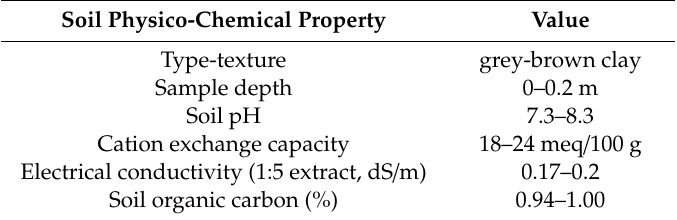
Figure 1. Map showing the lower Burdekin River delta and study site (red circle) location in northern Australia. Grey shading represents intensive agricultural land use. Table 1. Selected soil properties of site samples (top and bottom of paddock).